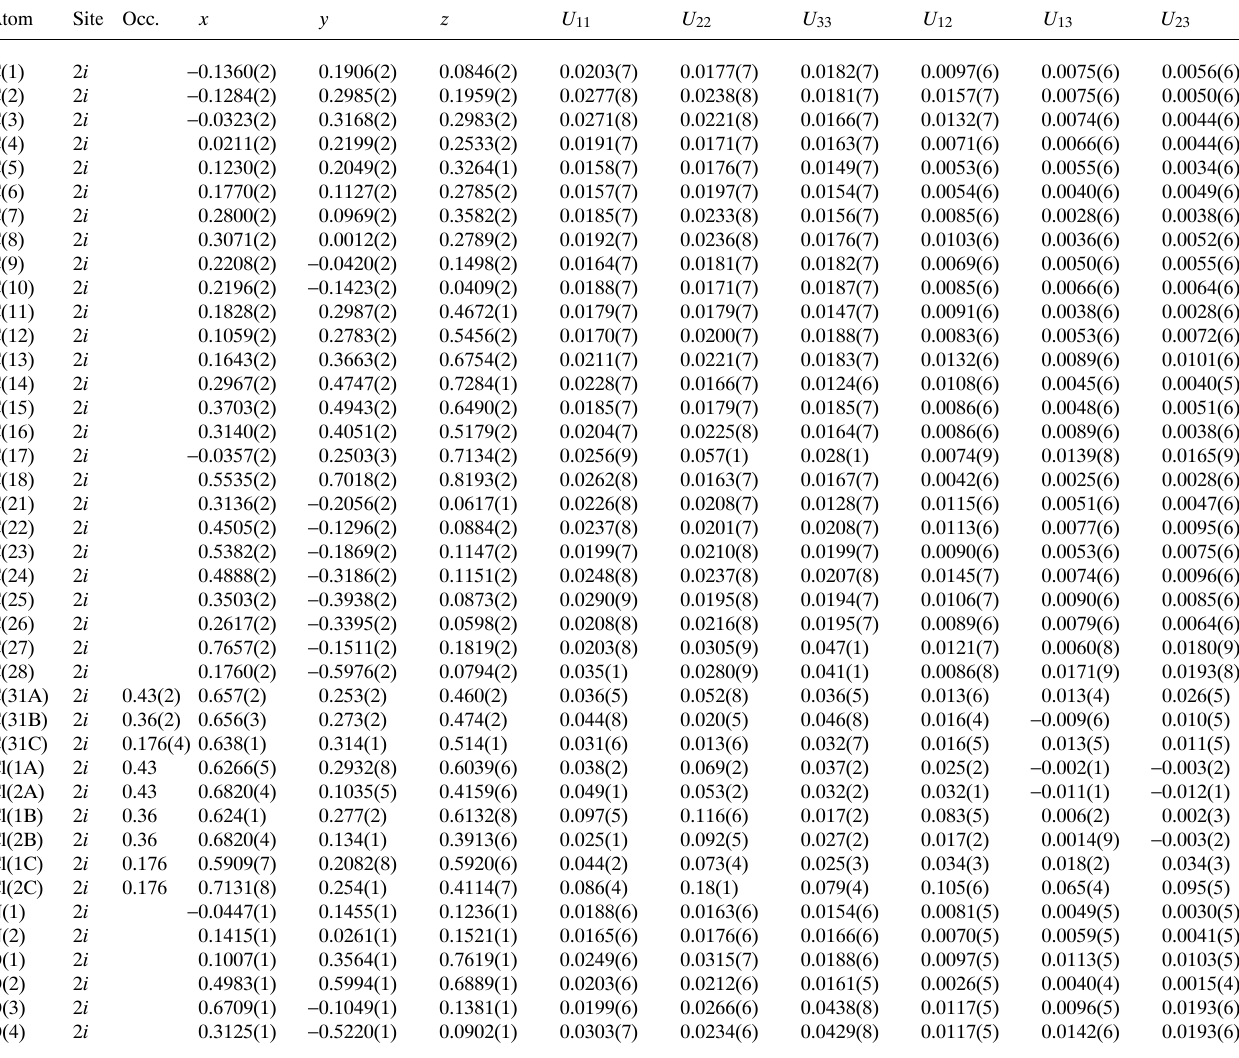
Table 3. A tomic coordin a tes a nd displ a cement p a r a meters (in Å 2 ) . A tom S ite O cc.